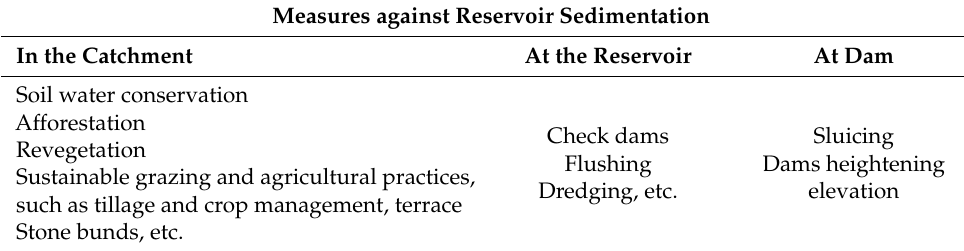
Table 3. Possible mitigation options for sediment